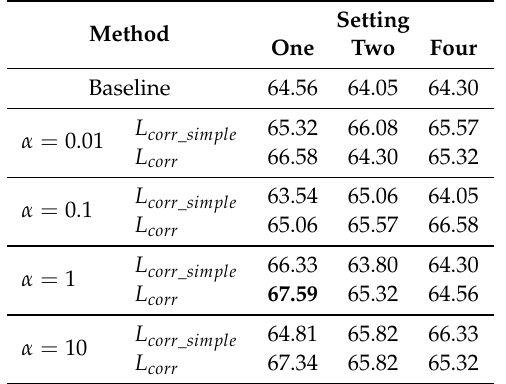
Table 5. The performance of audio-visual emotion recognition with different settings on the BAUM-1s dataset.